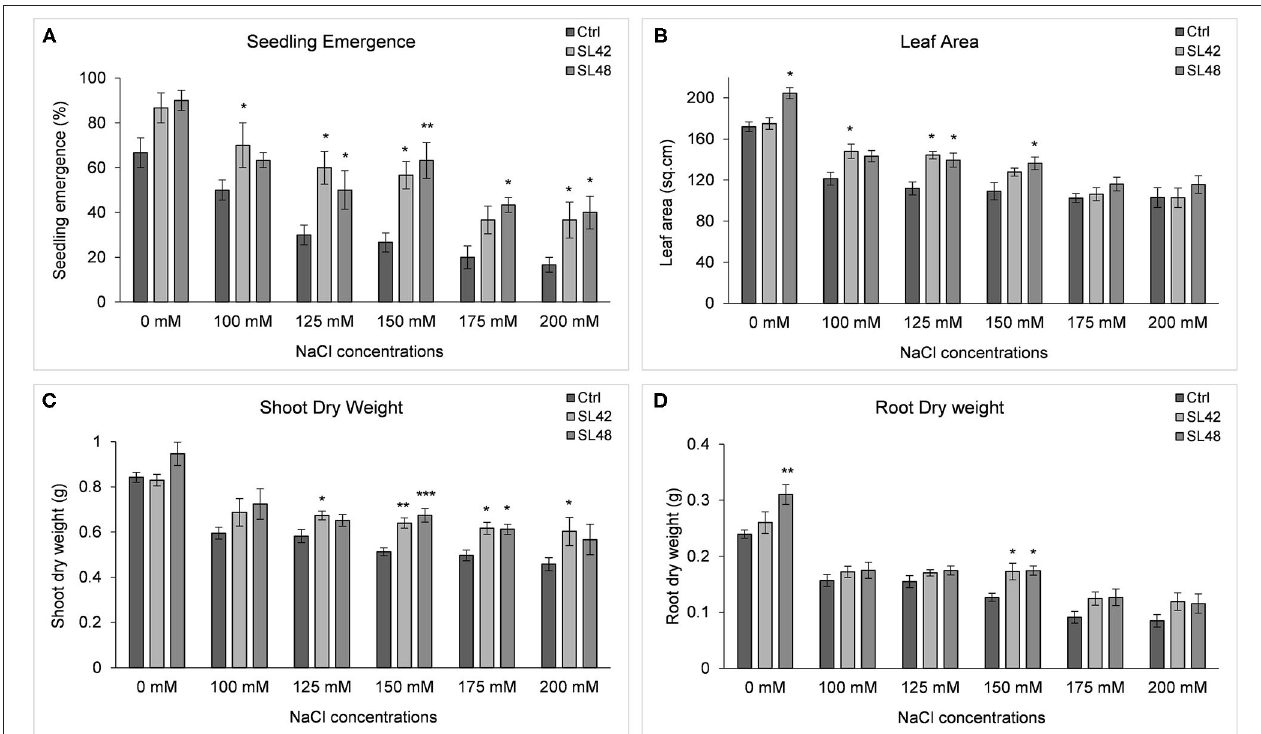
FIGURE 5 | Growth variables of soybean, (A) Seedling emergence rate measured on 8 th DAP and growth variables of soybean (B) Leaf area, (C) Shoot dry weight, and (D) Root dry weight measured at 28 th DAP under increasing salt concentrations (0, 100, 125, 150, 175, and 200mM NaCl). The seeds were treated with 10mM MgSO 4 as control or bacterized with strains SL42 and SL48. Values represent mean ± SE ( n = 6). Significant differences (increase) between the bacterial treatments and the respective control treatments of a particular salt concentration are indicated by asterisk above the data points, * p ≤ 0.05, ** p ≤ 0.001, *** p ≤ 0.0001 ( α =